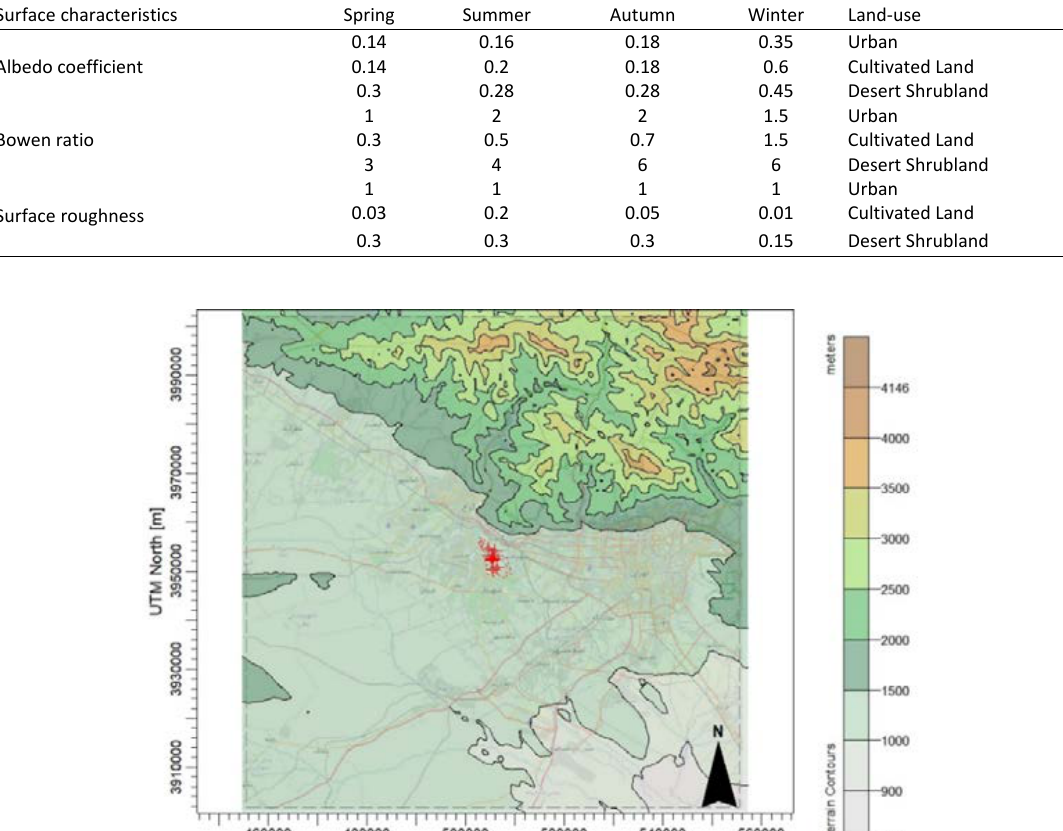
Table 4: Values for surface roughness length, Albedo, and Bowen ratio